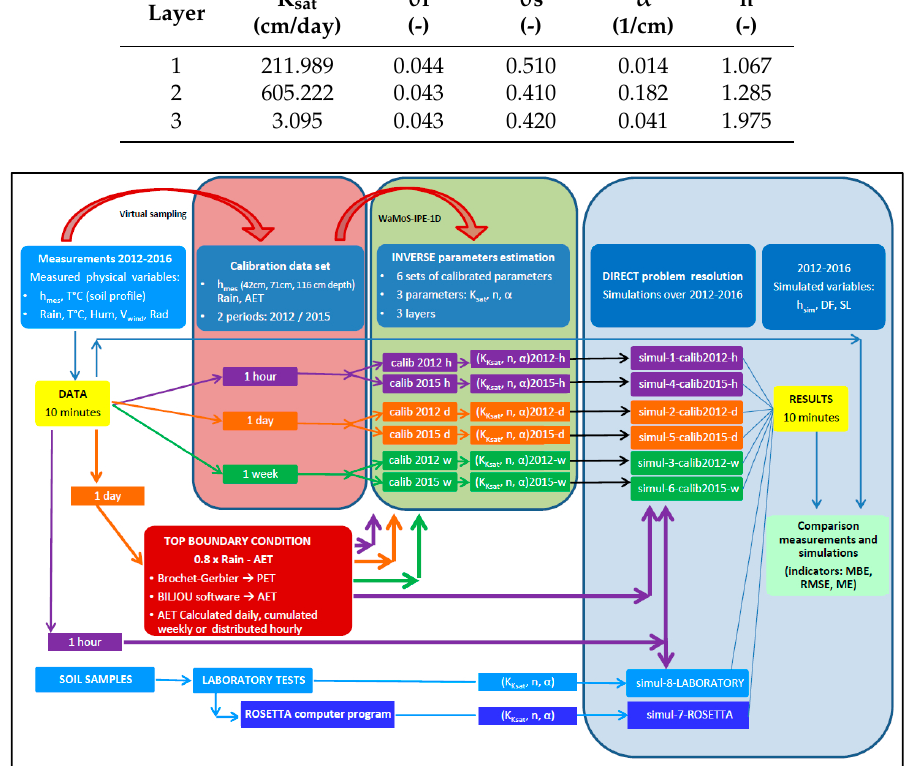
Table 2. Initial values of the hydraulic parameter estimation procedure using inverse modeling.